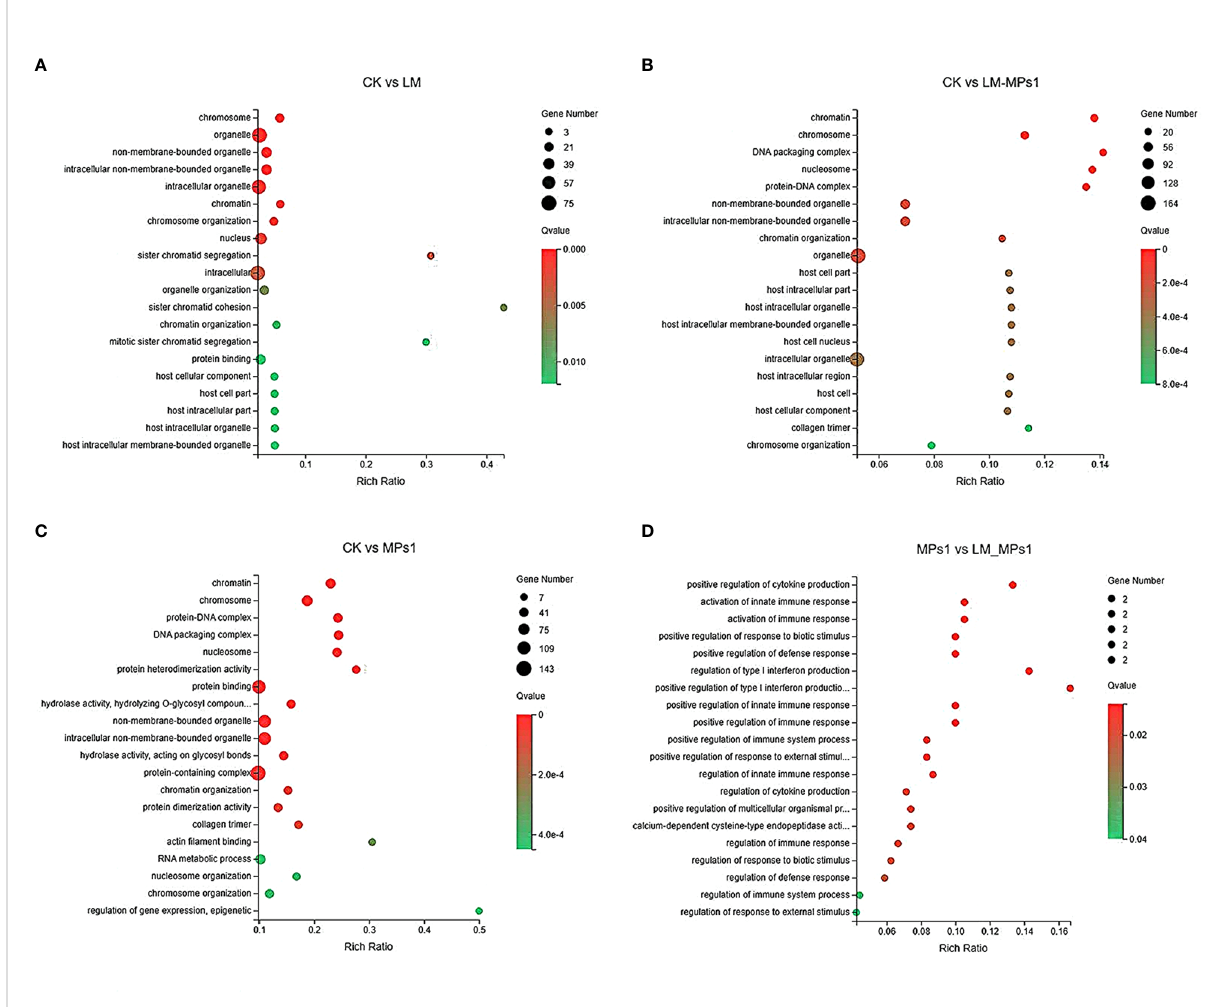
FIGURE 4 Bubble diagram of top 20 GO terms enriched by DEGs in different pairwise comparisons of the digestive gland (A-D) .